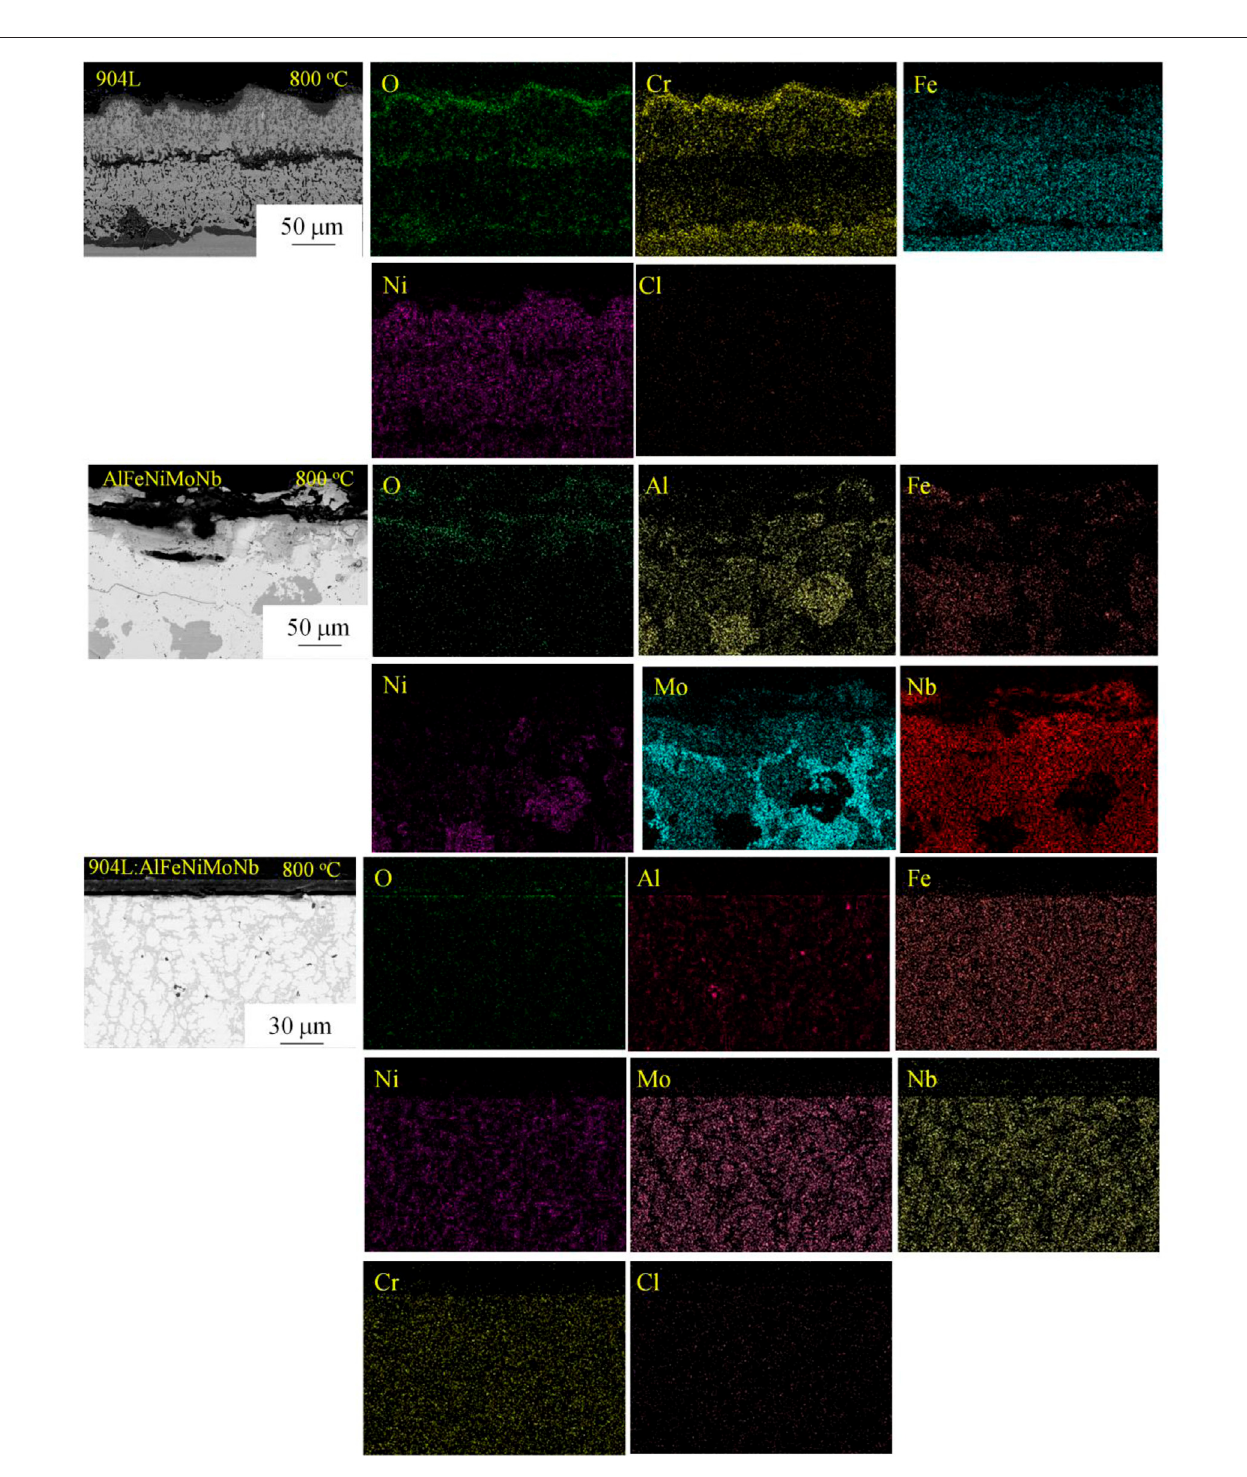
FIGURE 16 | Element mapping of the cross-section of the corroded samples corroded under N 2 – 2.6 vol.% CO 2 – 1.3 vol.% O 2 – 2,700 vppm HCl gaseous environment at 800 ° C for 55 h.